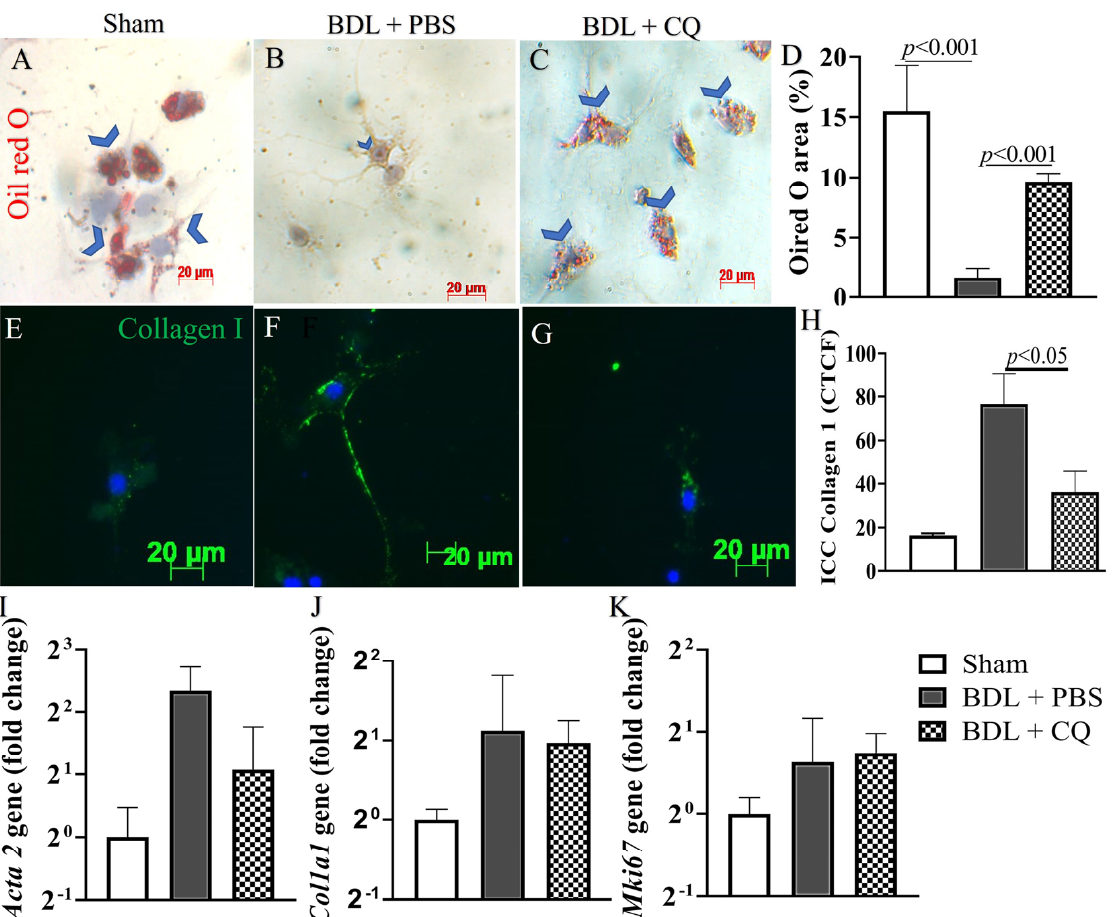
Figure 5. Effects of CQ on HSC in vivo activation. ( A – C ) Representative images of Oil red O staining in HSC isolated from the three mice groups: Sham, BDL/PBS, and BDL/CQ; blue arrows indicate the positive areas. ( D ) Quantification of the surface of Oil red O staining areas, p < 0.05, n = 3. ( E – G ) Representative images of type I collagen staining in HSCs isolated from the three mice groups: Sham, BDL/PBS, and BDL/CQ; ( H ) Quantification CTCF (Correct Total Cell Fluorescence quantification) of Collagen staining, p < 0.05, n = 3. ( I – K ) mRNA levels of acta 2 , col1a1, and Mki-67 markers in HSCs isolated from Sham, BDL/PBS, and BDL/CQ mice.